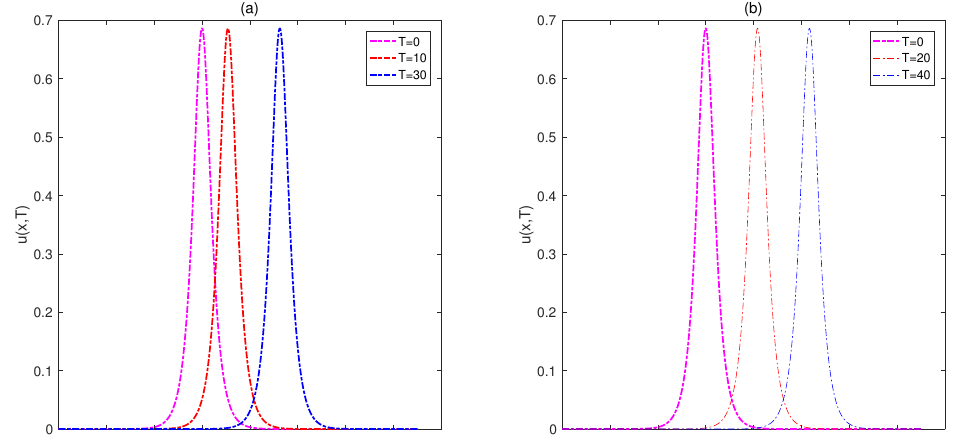
-0.4-0.3-0.2-0.100.10.20.30.4